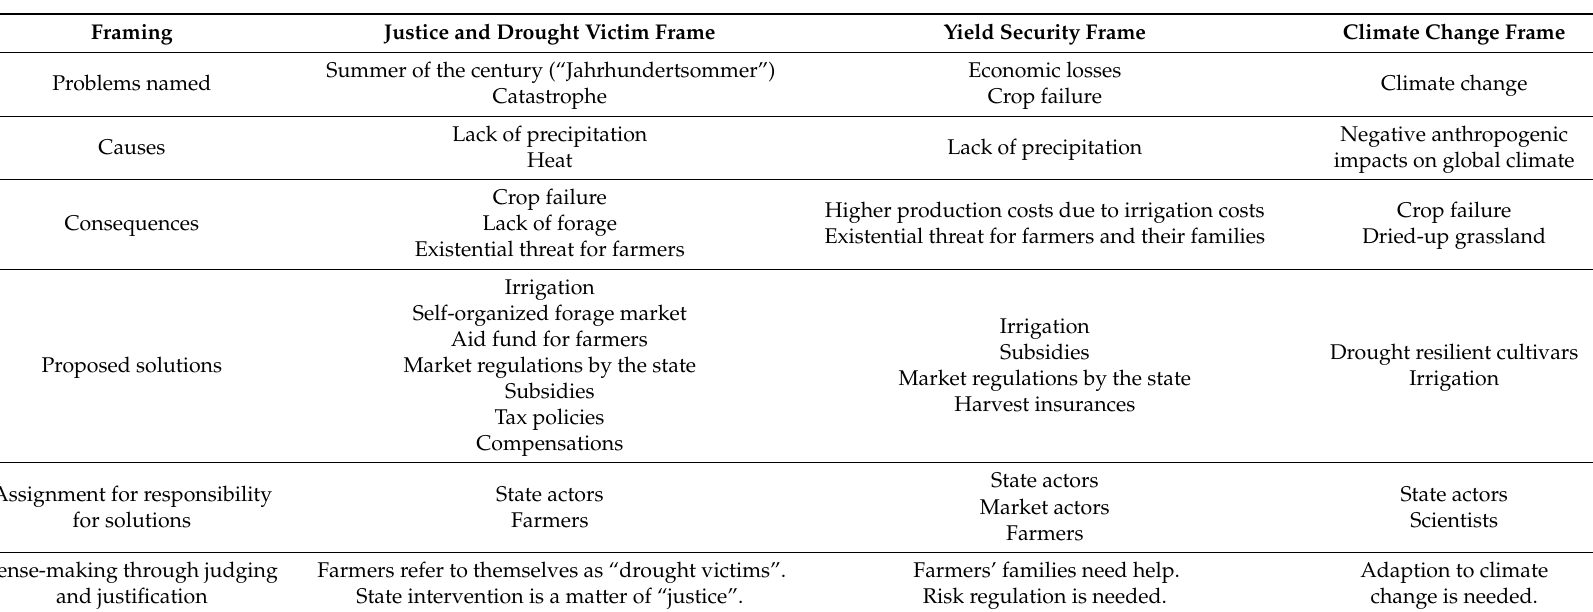
Table 3. Framing of drought by farmers in Baden-Württemberg 2003–08. Context: Within the investigation period 2003–08, there was the so-called Jahrhundertsommer (summer of the century), an extreme weather event characterized by a drought and a heat wave that impacted the European